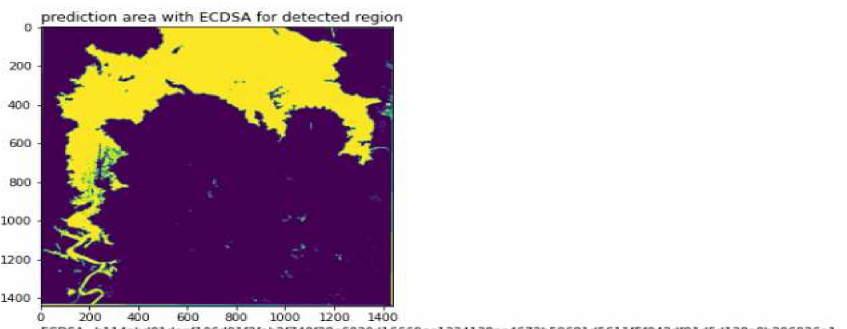
Figure 10. Predicted mask with ECDSA value—Case